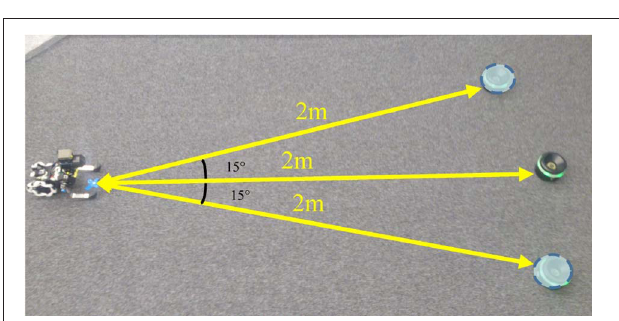
FIGURE 10 | Initial position of the Spring Dog and battery in the test phase. Three possible positions of the battery pack are considered.